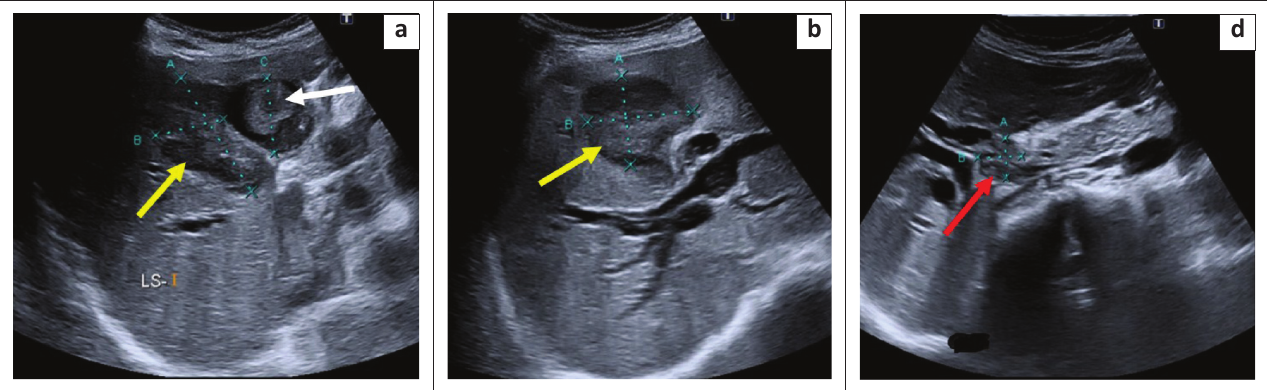
FIGURE 3: Example of a malignant cause of biliary obstruction: (a) Gallbladder mass (white arrow) which has invaded segments 4A and B of the liver (yellow arrow in image a and b) and the porta hepatis (red arrow in image c), causing obstruction of the common bile